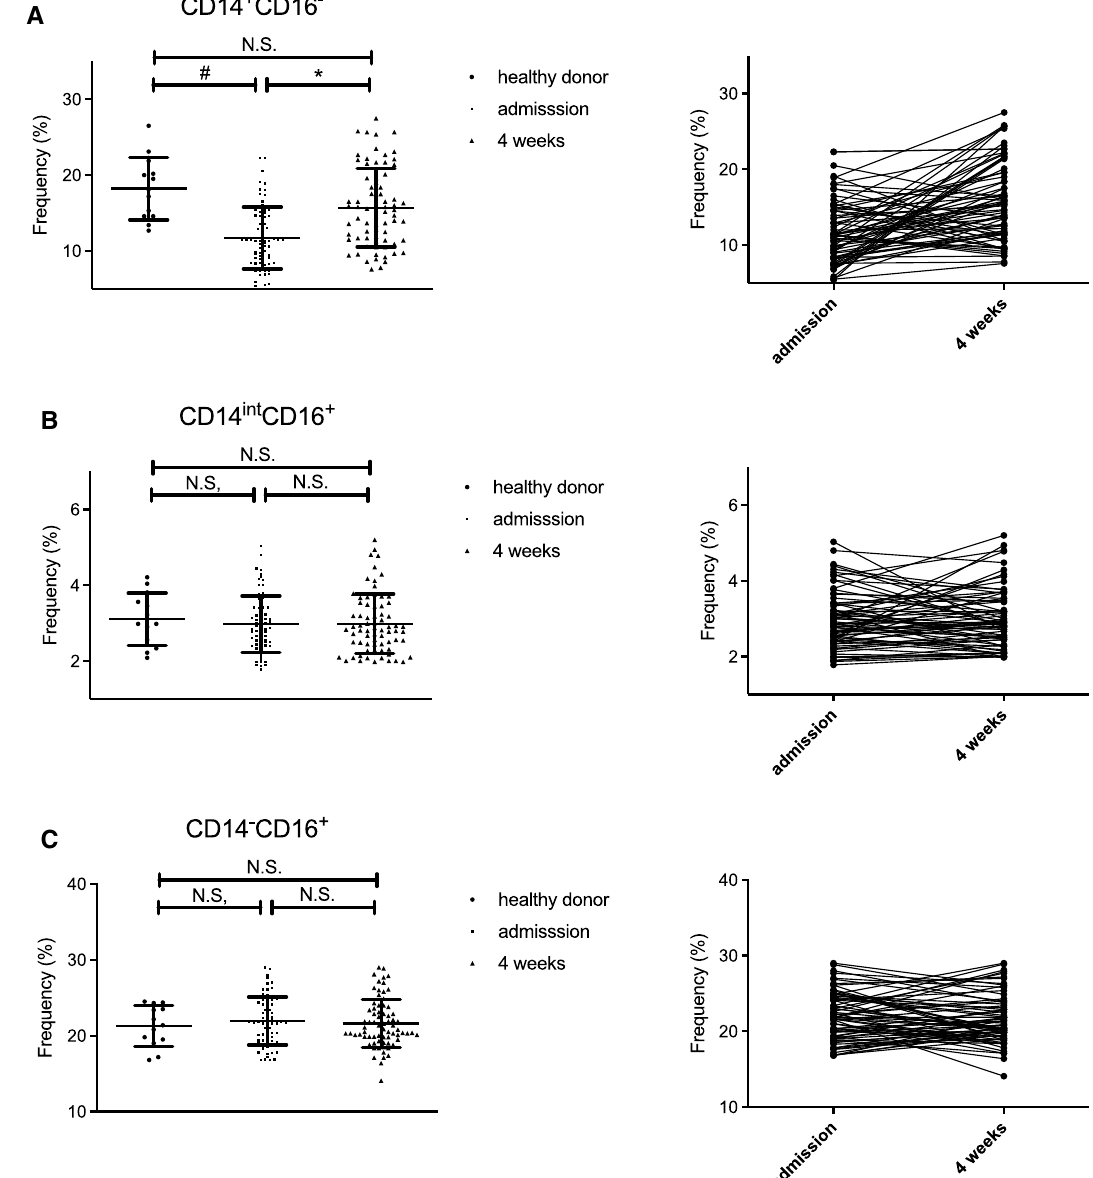
Figure 1. The number of peripheral CD14 + CD16 − monocytes is decreased in alcohol-dependent patients, and partially recovered following alcohol abstinence for 4 weeks. Blood samples were collected from healthy male donors (n = 13) and alcohol dependent patients (n = 72). Left; frequency of CD14 + CD16 − monocytes ( A ), CD14 int CD16 + monocytes ( B ), and CD14 − CD16 + monocytes ( C ) in the indicated groups. Data represent the mean ± SD. # p < 0.05 by Student’s unpaired t-test. Right; individual change in the frequency of CD14 high CD16 − monocytes ( A ), CD14 high CD16 + monocytes ( B ), and CD14 low CD16 + monocytes ( C ) following abstinence. * p < 0.05 Student’s paired t-test (admission vs 4 Alb (Fig. 4A). Monocytes incubated with LPS and MAA-Alb showed higher expression of TNF-α and IRAK-M than those stimulated with LPS alone (Fig. 4B,C). Conversely, monocytes incubated with MAA-Alb and LPS produced lower amounts of TNF-α following secondary LPS stimulation (Fig. 4D). These results collectively reinforce the direct contribution of acetaldehyde to the immune response of monocytes upon continuous LPS stimulation.